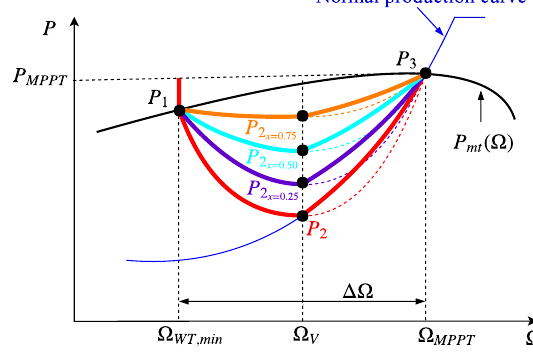
Figure 7. Different proposals for recovery operation mode